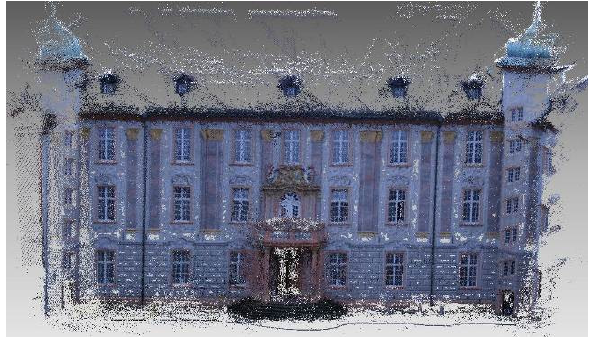
Figure 8. DSM of one of the façade of the inner courtyard of the Ettlingen